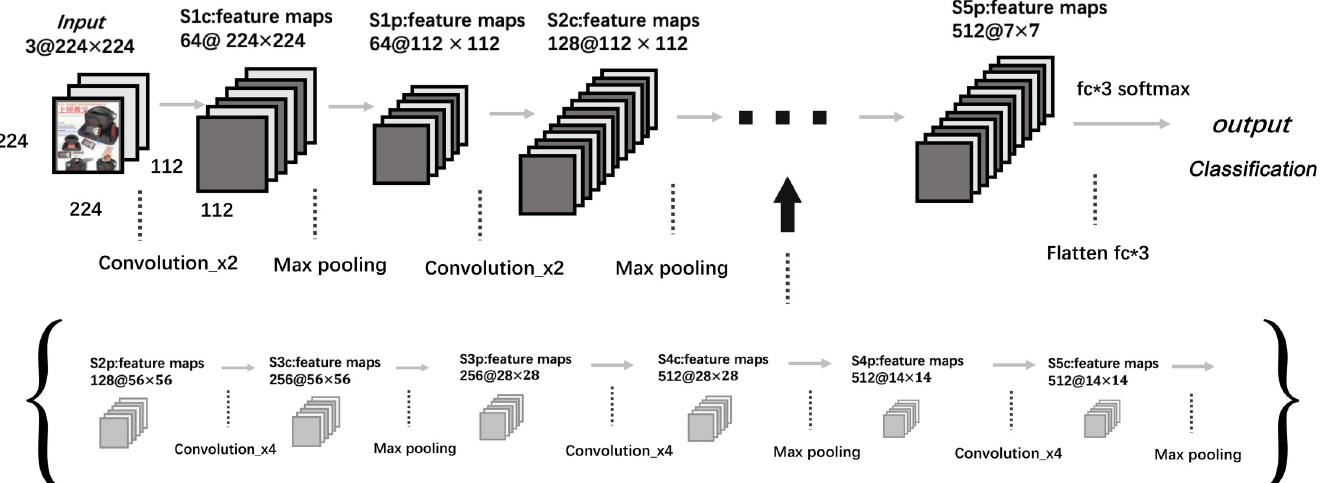
Fig 1. Architecture of the VGG-19 networks. Each plane is a feature map.